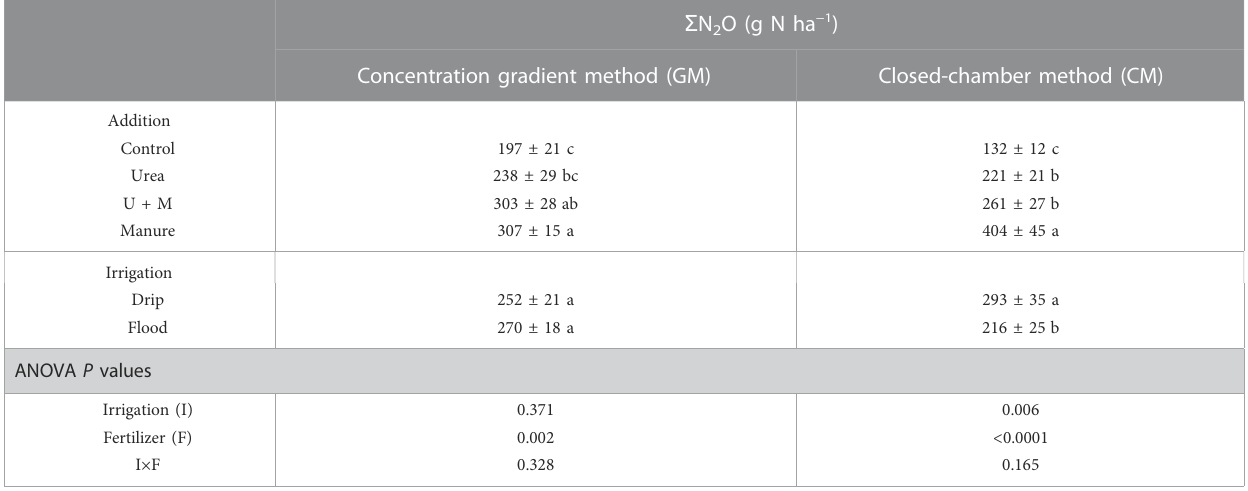
For each treatment factor, means within a column followed by the same letter are not signi fi cantly different at p < 0.05.